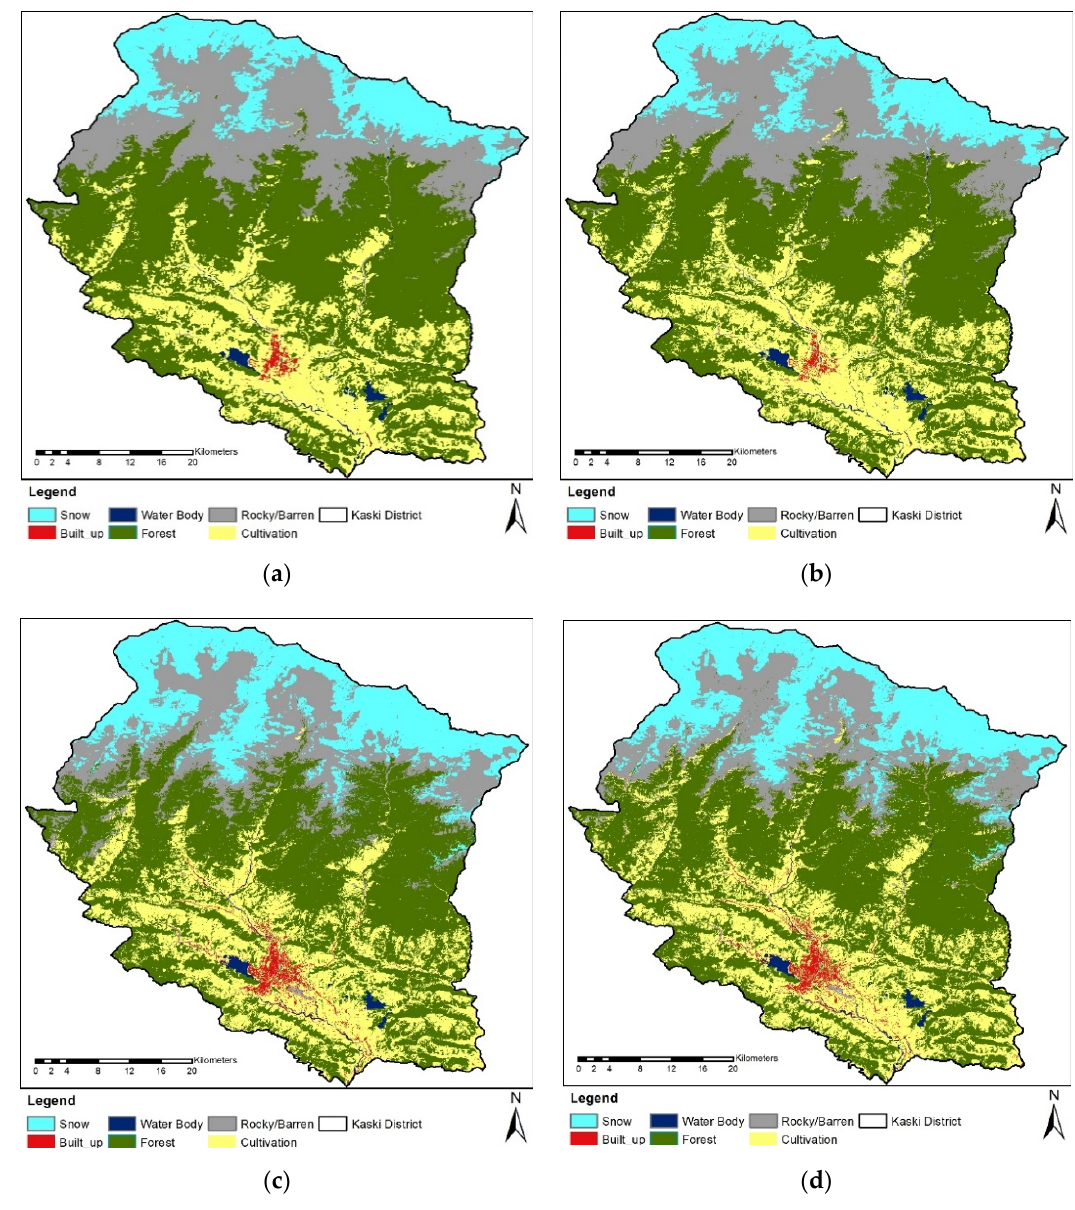
Figure 7. LC Maps of Kaski district for two different time frames. ( a ) For 2010 using RF classifier; ( b ) for 2010 using XGBoost; ( c ) for 2020 using RF; ( d ) for 2020 using XGBoost. Table 4. Table showing overall accuracy, Kappa and no-information rate (NIR).